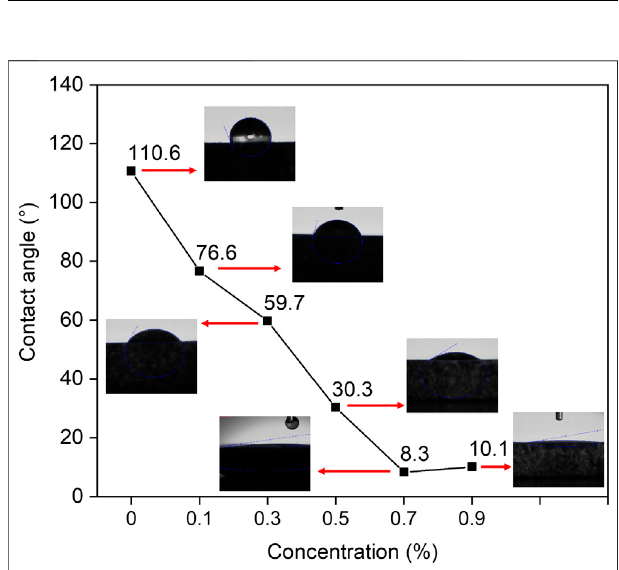
FIGURE 8 | Contact angles in different concentrations of nano fl